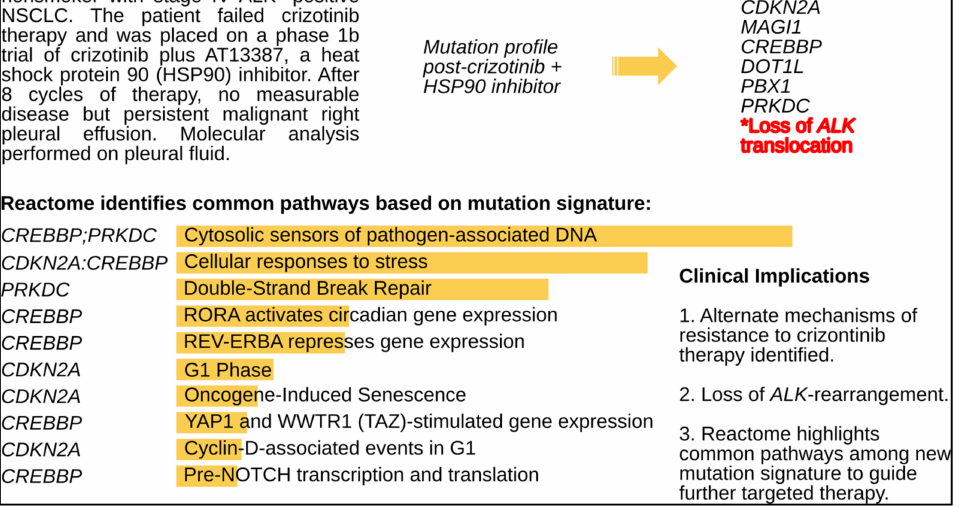
DNA damage response and aberrant cell cycle may have benefitted this